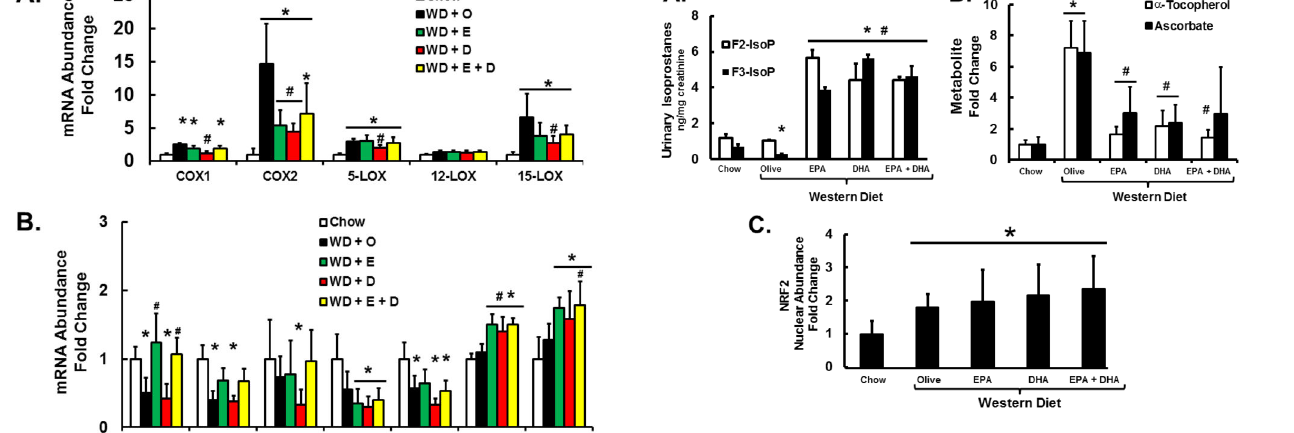
Figure 17. Diet effects on urinary isoprostanes and hepatic α-tocopherol, ascorbate and Nrf2. Panel A: Levels of 24-Hour urinary F2- and F3-IsoPs were quantified as described [17]. F2-IsoPs are derived from arachidonic acid (20:4 n-6) and F3-IsoPs are derived from eicosapentaenoic acid (20:5 n-3) (Fig. 14). Results are represented as Urinary Isoprostanes (ng/mg creatinine) mean + SD, n=3; urine from 2 pools of mice (3 mice/pool) from each diet group were assayed. Panel B: Hepatic α-tocopherol (vitamin E) and ascorbate (vitamin C) were quantified by the metabolomic analysis (Methods) and represented as Metabolite-Fold Change, relative to chow-fed mice; mean ± SD; n=8/group. Panel C: Hepatic nuclear abundance of Nrf2. Hepatic nuclear extracts were assayed for Nrf2 and the loading control protein, TATA-binding protein (TBP) using methods previously described [17]. Nrf2 nuclear abundance was normalized to TBP for each sample. Results are represented as Nrf2 Nuclear Abundance-Fold Change, mean + SD, n=8 group; *, P ≤ 0.05 versus chow; #, P ≤ 0.05 versus WD + O. doi: